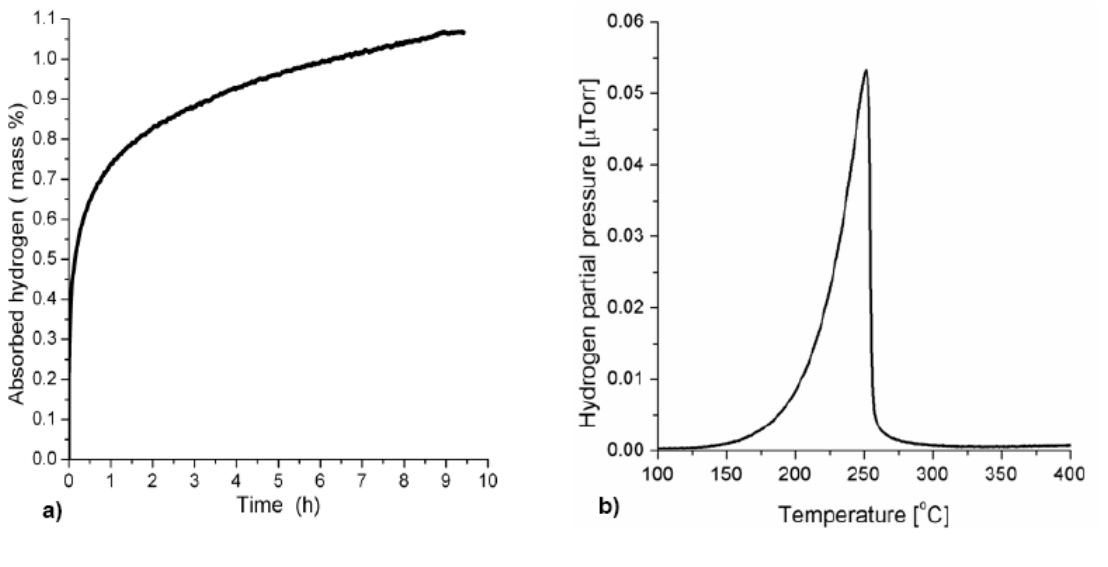
Figure 11. (a) Hydrogen absorption curve for the 2Mg-Fe elemental nanocomposite at 30 °C under 4 MPa of hydrogen pressure up to 10 h. (b) Temperature programmed desorption (TPD) spectrum of 2Mg + Fe nanocomposite sample hydrogenated at 30 °C under 4 MPa of hydrogen pressure up to 10 h (heating rate of 5 °C/min under flowing helium). Adapted from